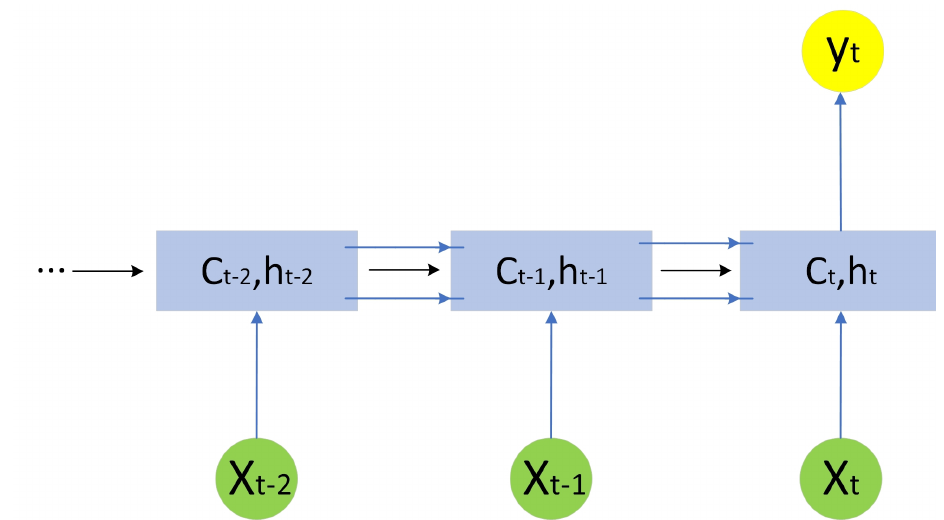
Figure 5. The LSTM neural network’s output is the output of the last cell.